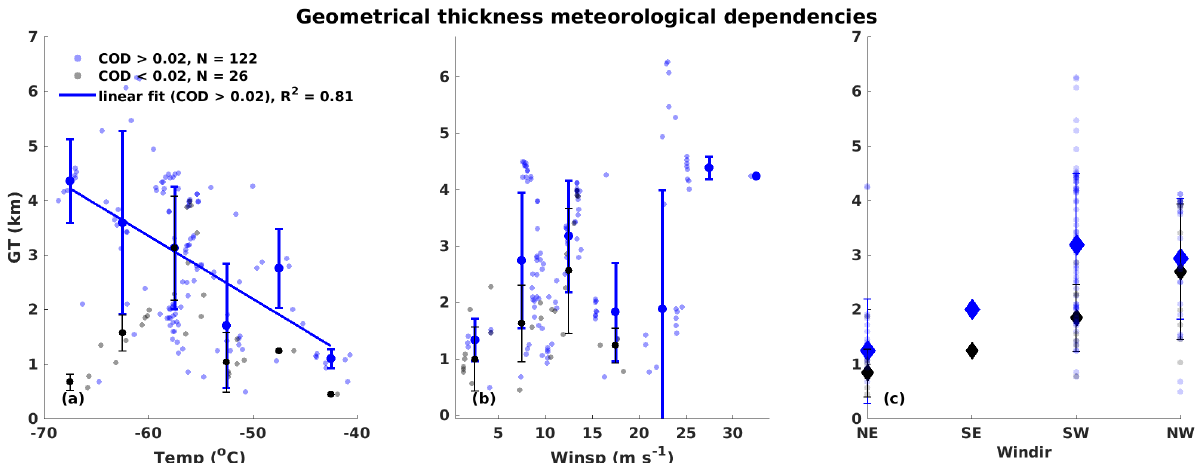
Figure 9. Cirrus layer GT versus layer median temperature ( a ), wind speed ( b ) and wind direction ( c ). Overlaid is the median ± standard deviation of GT per temperature (5 ◦ C), wind speed (5 ms − 1 ) and wind direction classes. Observations corresponding to both COD regimes are shown. Only observations satisfying the 2 h temporal criterion are